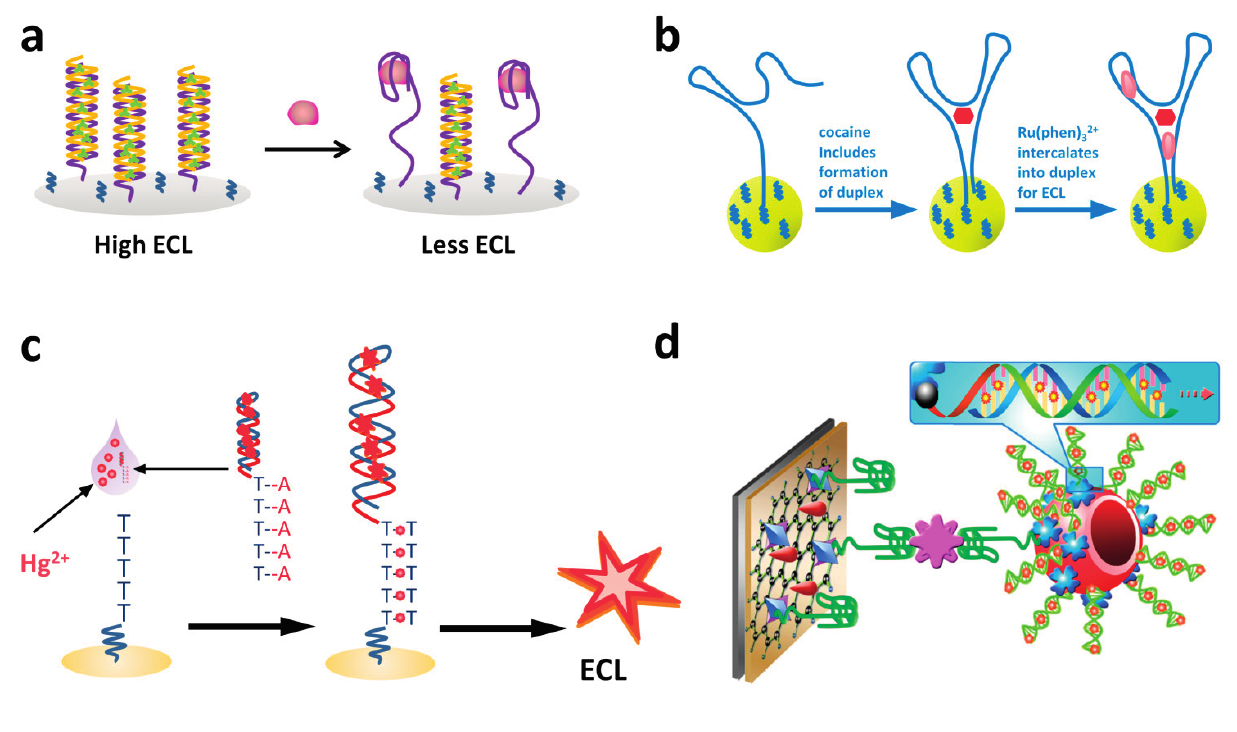
Figure 21. Label-free ECL aptasensing platforms using Ru(phen) 32+ as ECL luminophore. ( a ) signal-off platform for protein detection; ( b ) signal-on platform for small molecules (such as cocaine) detection; ( c ) signal-on platform for mercury ions detection; ( d ) signal-on platform for thrombin detection. ( a ) reprinted with permission from ref. [219], copyright (2009) American Chemical Society; ( b ) reprinted with permission from ref. [221], copyright (2011) Royal Society of Chemistry; ( c ) reprinted with permission from ref. [220], copyright (2010) Royal Society of Chemistry; ( d ) reprinted with permission from ref. [225], copyright (2013)